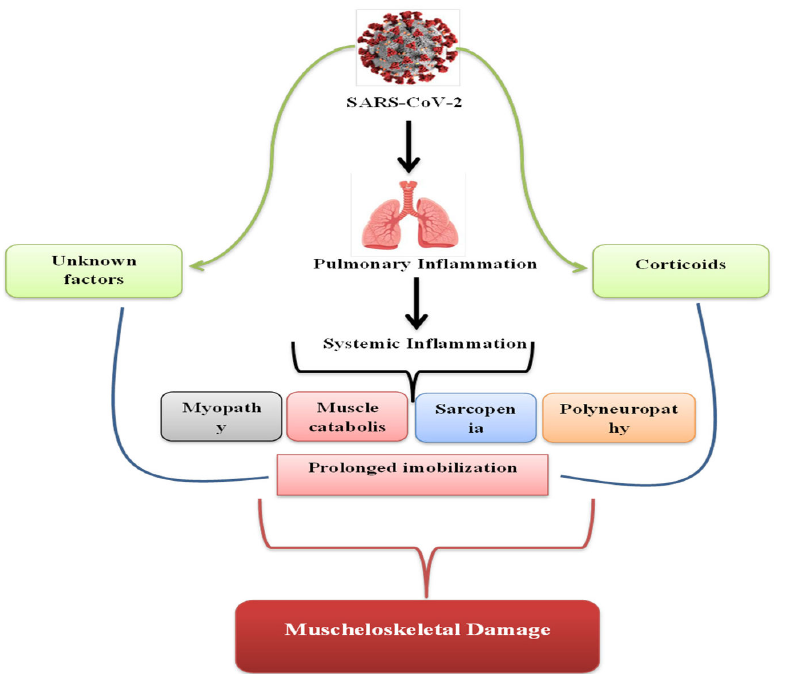
Figure 1. Pathogenic components leading to musculoskeletal injury in severe cases of